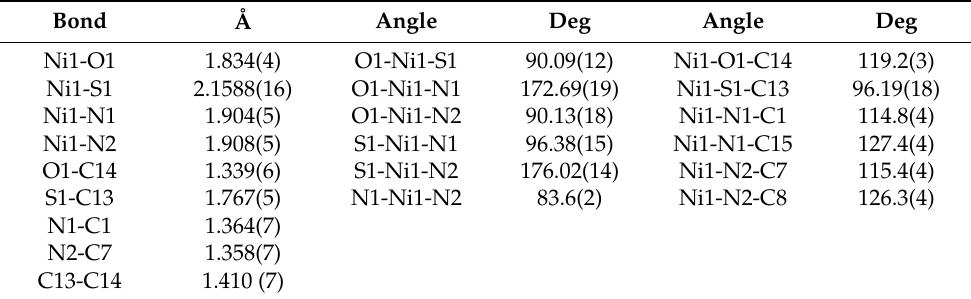
Figure 3. ORTEP of 2 . Thermal ellipsoids are drawn from 50% probability. Hydrogen atoms omitted for clarity. Table 1. Selected bond lengths (Å) and bond angles (deg) of complex 2